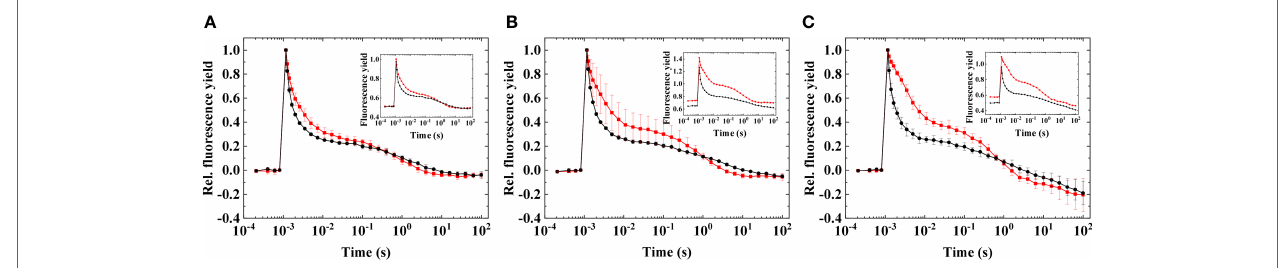
FIGURE 5 | Flash-induced fluorescence relaxation in three different species of Symbiodiniaceae under aerobic and microaerobic conditions, recorded at growth temperature. (A) Fugacium kawagutii (CS156), (B) Symbiodinium tridacnidorum (2465), and (C) Symbiodinium microadriaticum (2467), including control (black) and microaerobic condition (red). Main figures: Normalized fluorescence. Insets: Original data. The fluorescence traces were double normalized (F 0 to 0 and F m to 1) to achieve the same initial amplitudes (mean values of three biological replicates ± S.D.). Insets show original traces without normalization (representative